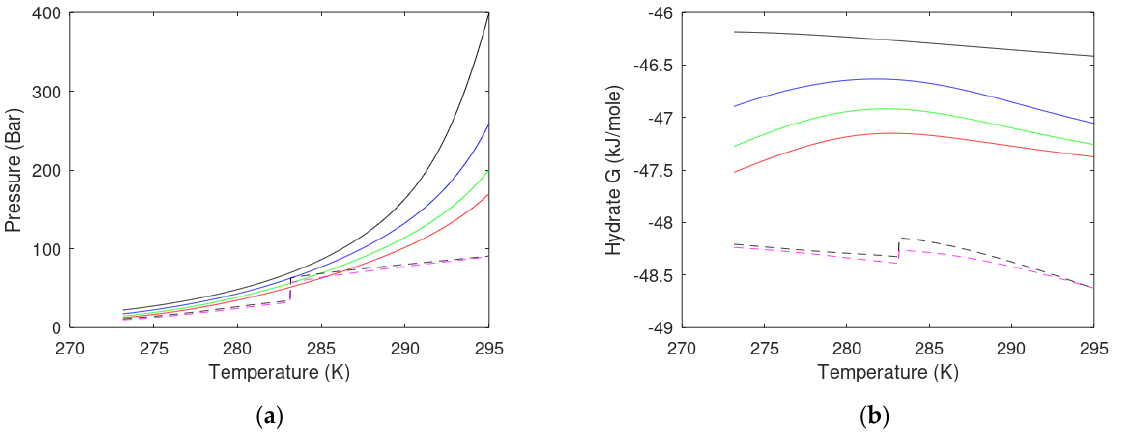
on CO 2 chemical potential is partly compensated for by some N 2 filling in small cavities.